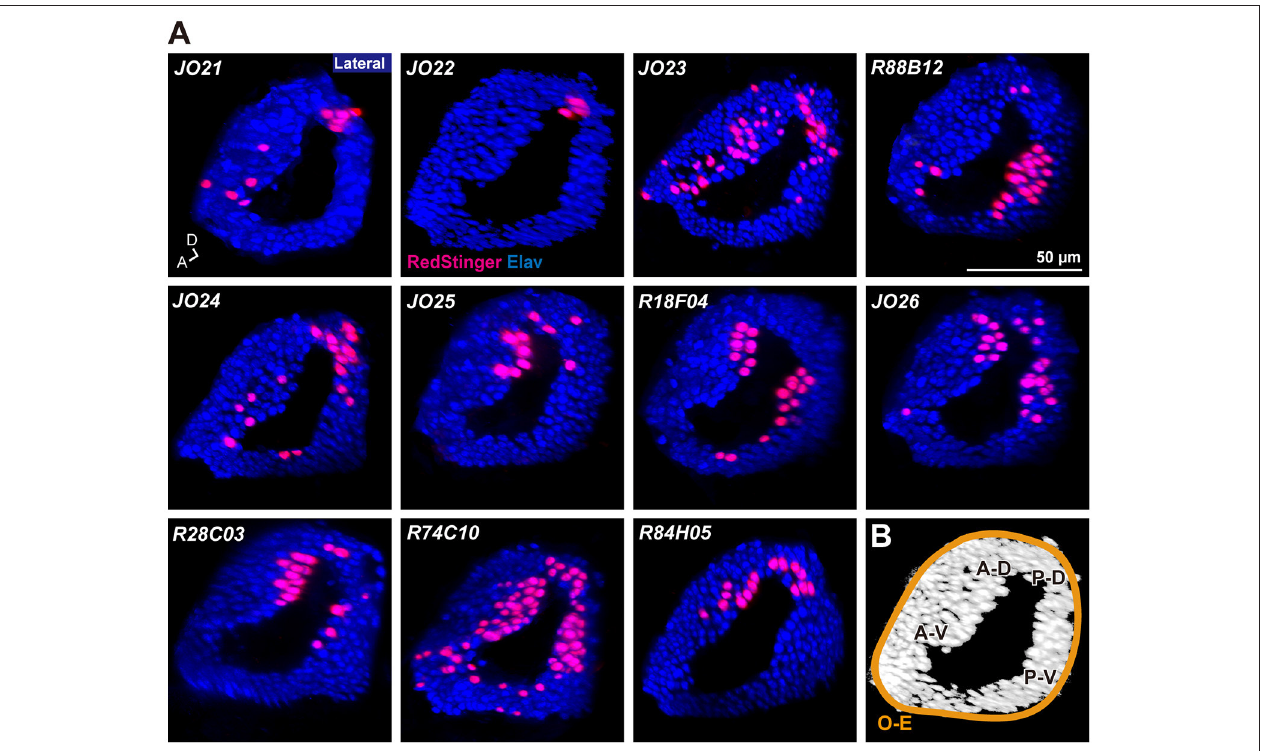
FIGURE 2 | Distribution of labeled cell bodies in JO. (A) Distribution of the labeled cells in the somata array of JO neurons. Magenta and blue signals show the cell bodies labeled by RedStinger and anti-Elav antibody, respectively. A, anterior; D, dorsal. (B) Somata regions of subgroup-A neurons. A-D, anterior-dorsal; P-D, posterior-dorsal; A-V, anterior-ventral; P-V; posterior-ventral; O-E,